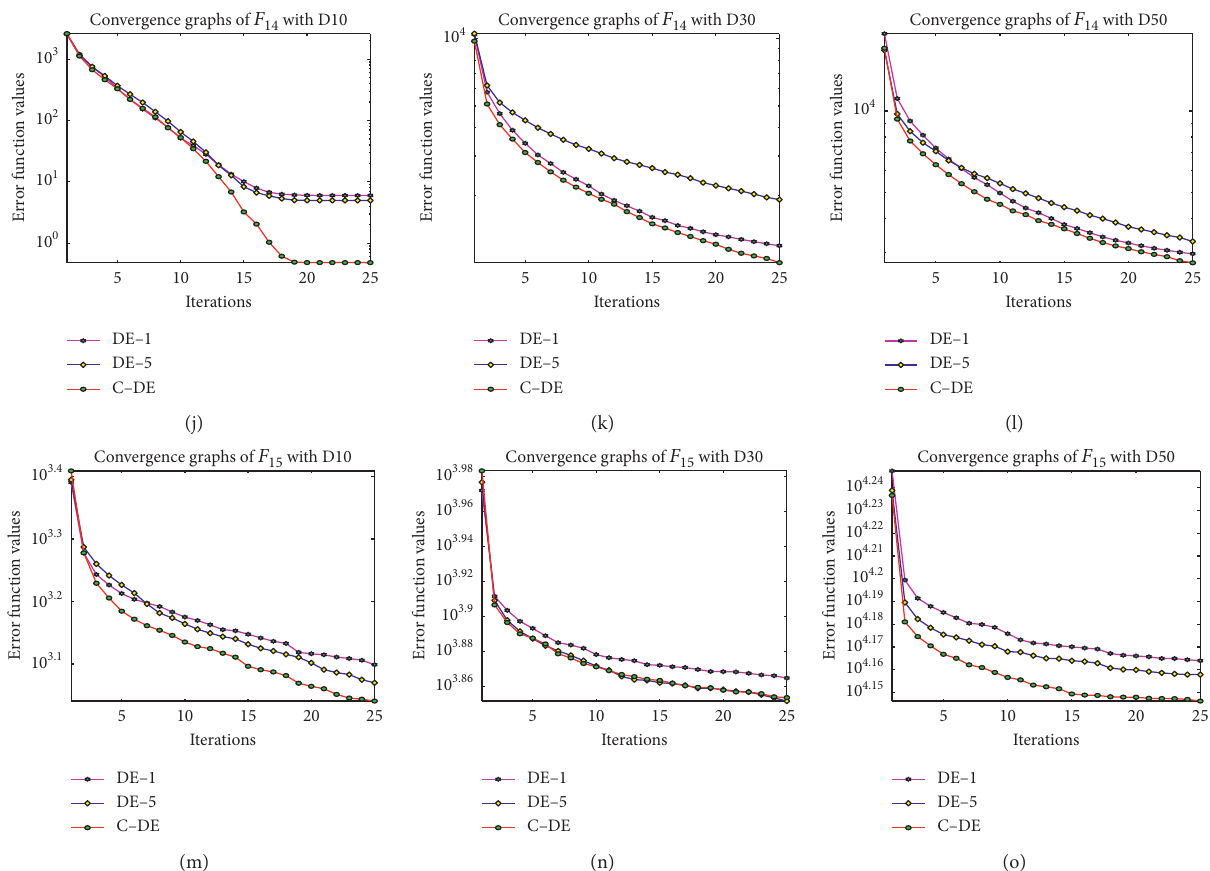
Figure 4: Evolution in the best function values of F